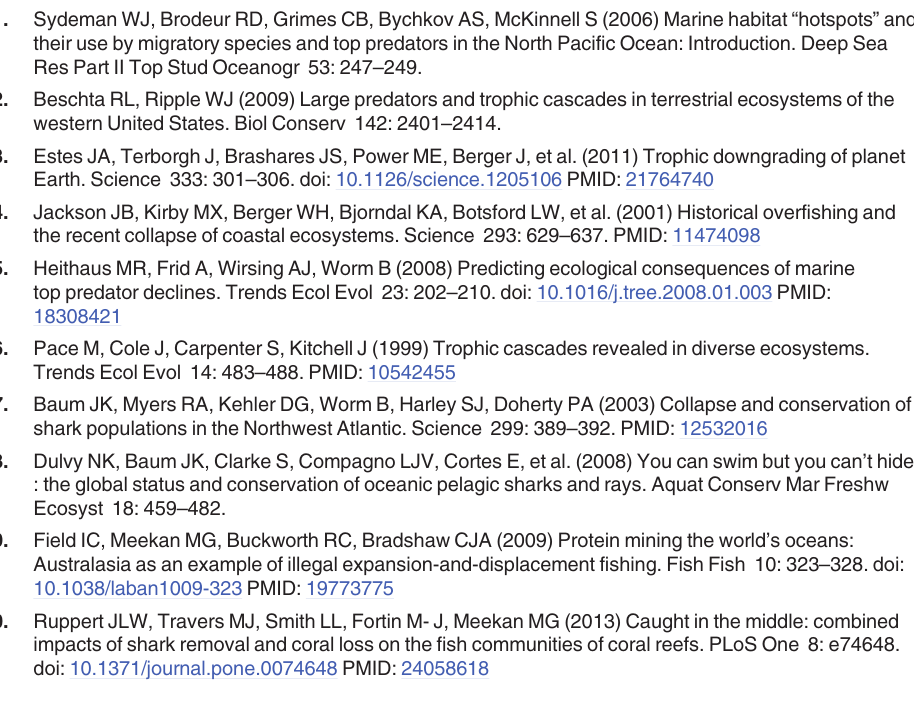
S1 Fig. Sea Surface Temperature map for 16 th May 2009 with location uplinks for Shark 5.